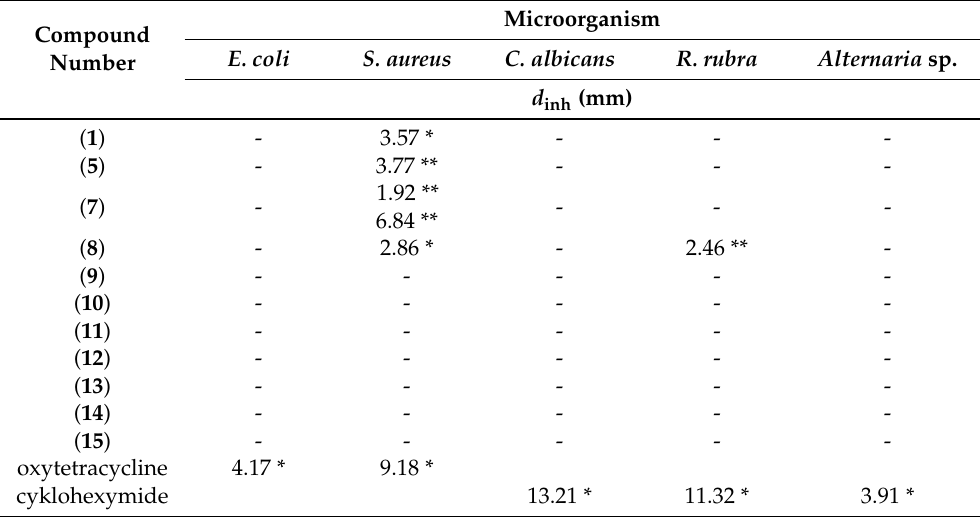
Table 1. Antimicrobial activity of tested